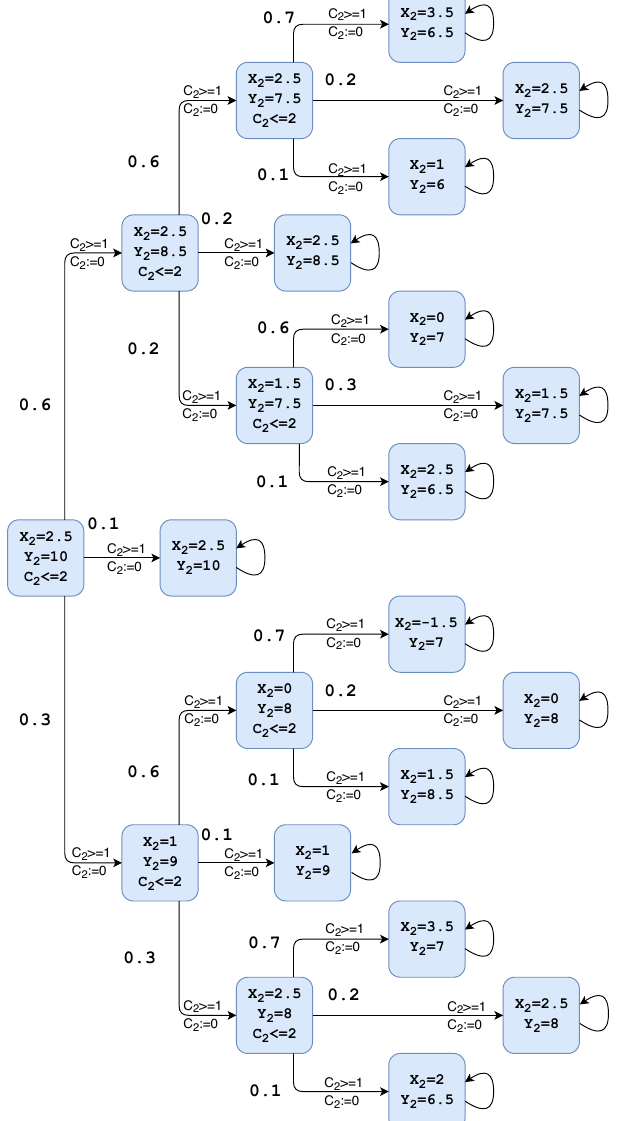
Figure 13. PTP model for the pedestrian’s